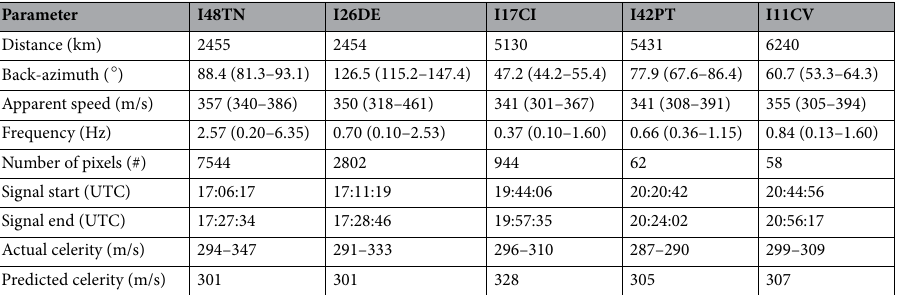
Parameter I48TN